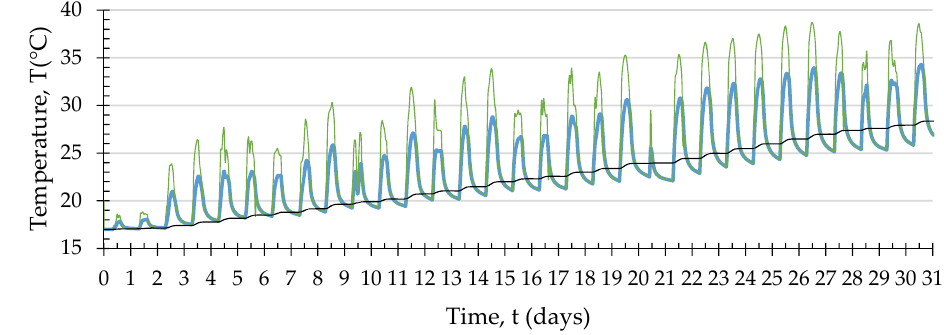
Figure 9. Available heat stored for different solar collector areas based on TES average temperatures for January.